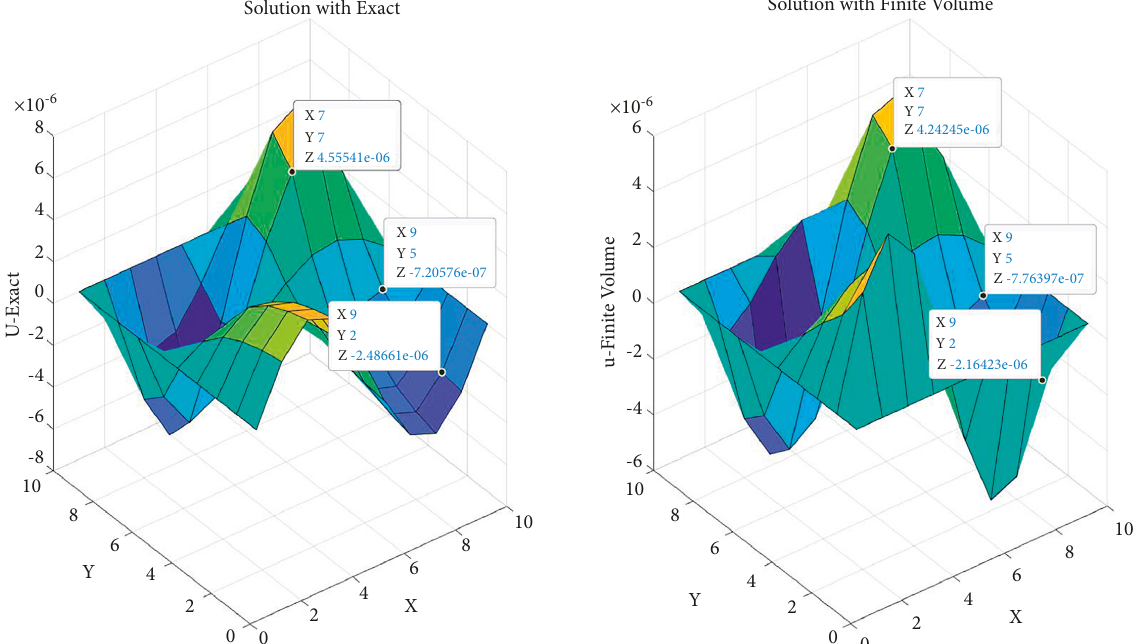
Figure 6: Analytical and approximate results of FVM at 20 × 20 grid size, time step � 0 . 01. ϵ � 0 . 1.